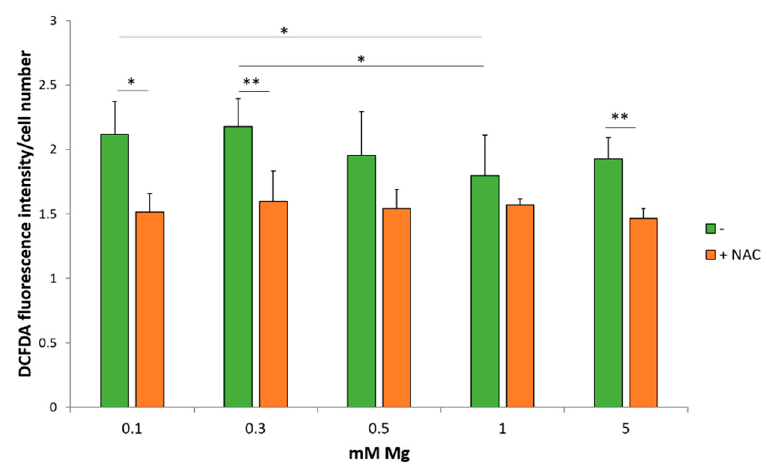
Figure 2. Low magnesium induces ROS accumulation. ROS production was evaluated using DCFDA in HUVEC maintained for 24 h in media containing different concentrations of Mg in the presence (orange columns) or in the absence (green columns) of NAC (5 mM). Fluorescence at 529 nm was measured and then normalized to the cell number. The experiment was performed three times in triplicates. * p ≤ 0.05 and ** p ≤ 0.01.